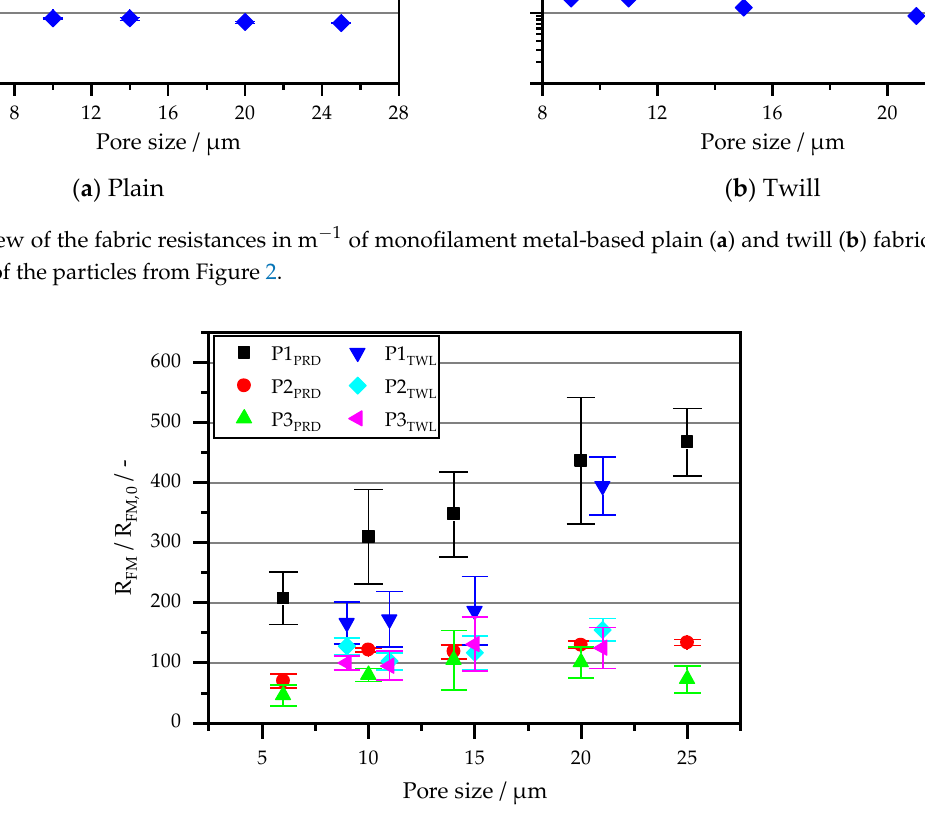
Figure 9. Relative change of the filter medium resistance with particle interaction R FM , related to the clear water resistance R FM,0 , over the mesh size of metal-based plain weave and twill weave.